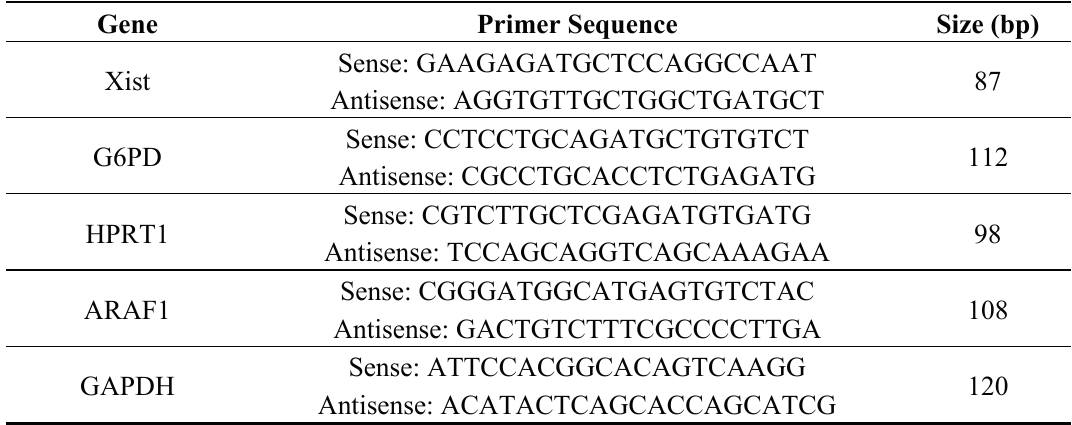
Table 5. Primer sequence of Xist, G6PD, HPRT1 and ARAF1 for q-PCR